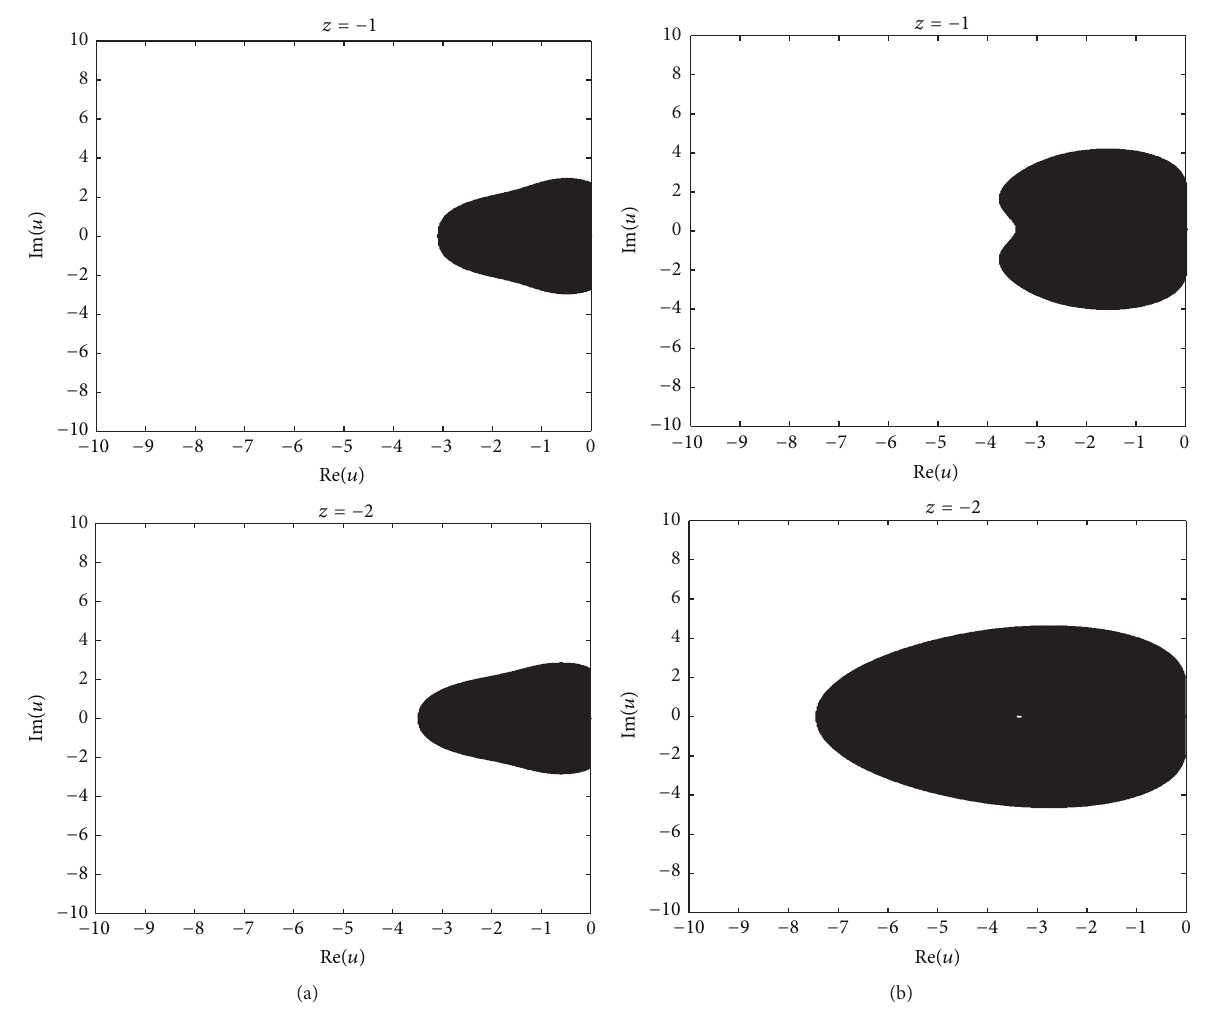
Figure 1: Stability regions of the SEFTDRK4 (a) and the REFTDRK4 (b) projected on the planes 𝑧 = −1 and 𝑧 = −2